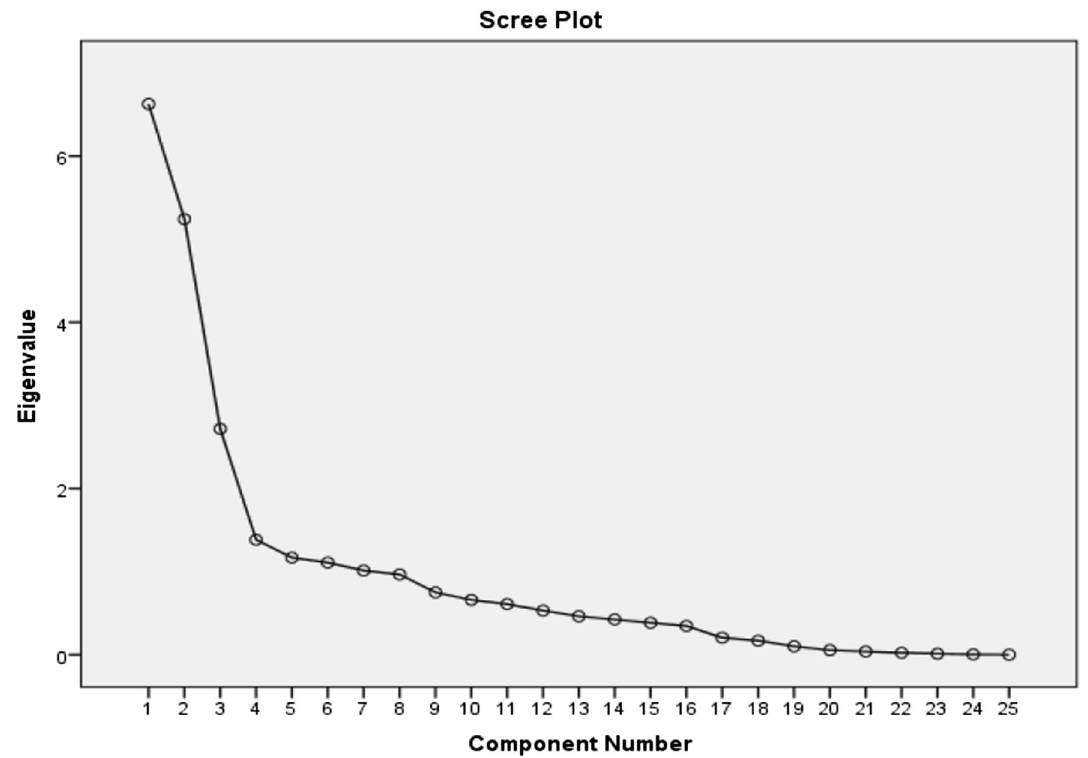
Fig. 2 Scree plot of eigenvalues of physico-chemical variables of surface water of summer water in Leh, Jammu & Kashmir,